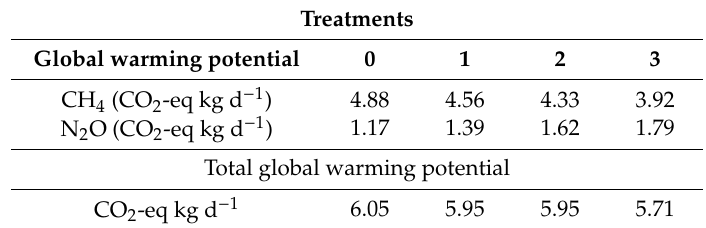
Table 9. Estimate global warming potential in heifers fed with dried L. leucocephala leaves. Treatments Global warming